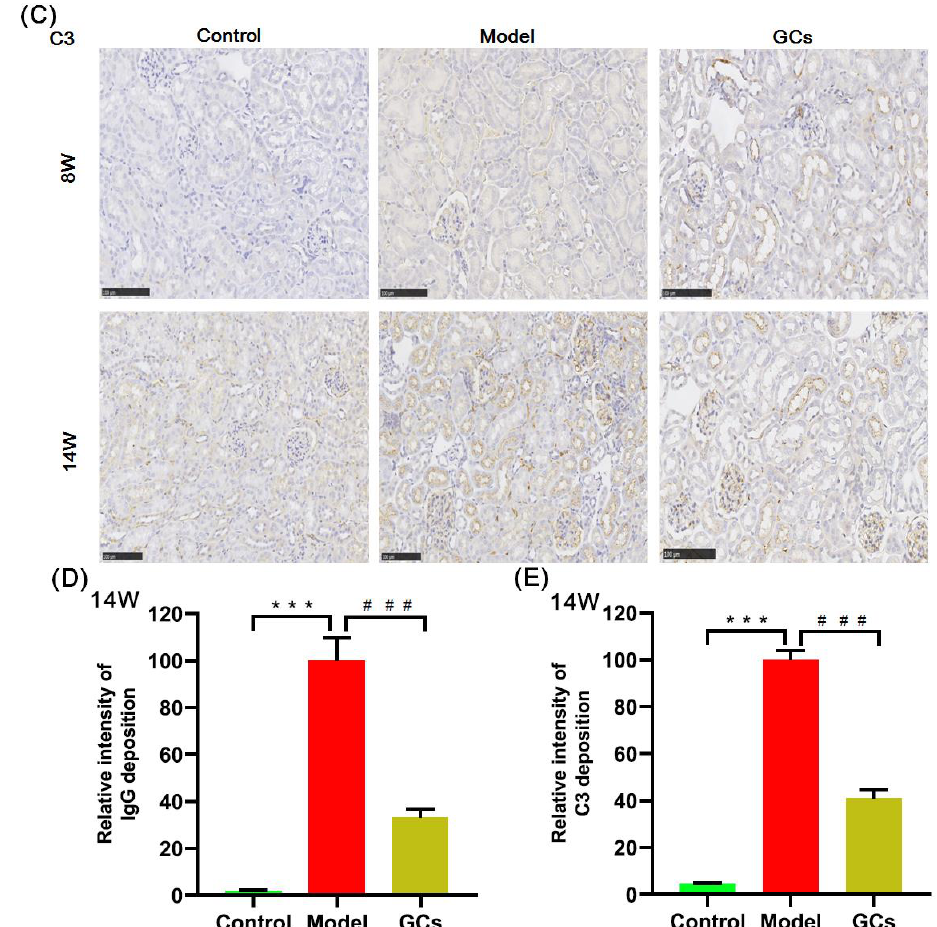
Figure 1. Representative images of renal histopathology of MRL/lpr mice from each group at two different time points. Renal tissues of the control ( n = 4), model ( n = 4), and glucocorticoids (GCs) ( n = 4) groups were collected at 8 and 14 weeks of age, respectively. Both model and GCs groups were MRL/lpr mice, while the control group was MRL/MpJ mice. Kidney pathological changes were de- termined by H&E staining (Panel A ). Images were captured under ×100 visual field with optical microscopy. IgG deposition in glomeruli was assessed through immunofluorescence analysis (nu- cleus stained with 4′, 6-diamidino-2-phenylindole, blue; IgG antibody, green) (Panel B ). Images were obtained under ×400 visual field with fluorescence microscopy. The C3 deposition in glomeruli as assessed by immunohistochemical staining (Panel C ). the representative images were captured under ×100 visual field. The intensities of IgG (Panel D ) and C3 deposition (Panel E ) on the glomeruli from two to four sections from each mouse were determined and displayed as normalized values of the model group. Difference between the groups was determined using ANOVA followed by Dunn multiple comparison with IBM SPSS Statistics 19 Software (SPSS Inc., Chicago, IL, USA) after the normality of each group of variables was checked by Q–Q plots. The raw p values were adjusted to false discovery rat using the Benjamini–Hochberg method. *** adjusted p < 0.001 and ### adjusted p < 0.001 compared with those in the control and the model group, respectively. H&E represents hematoxylin and eosin, and C3 denotes Complement C3.